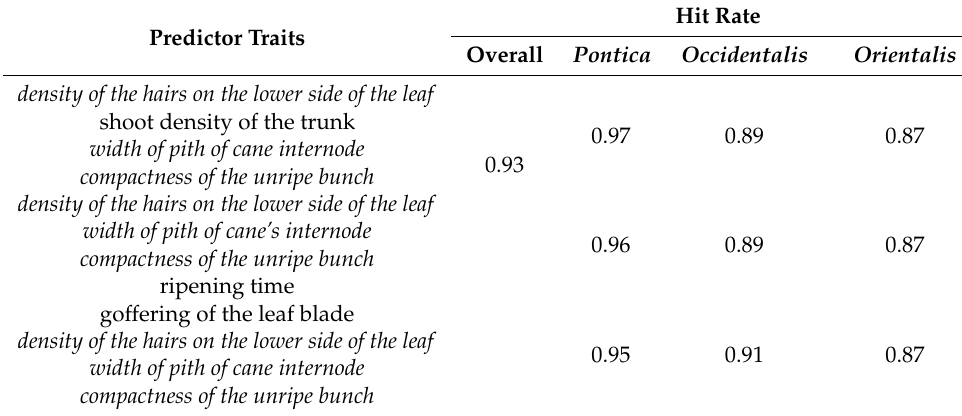
Table 1. The rate of correct classifications in the test set (overall hit rate) and the subsets pontica, occidentalis, and orientalis resulted in using four predictors with the random forest method. The best three-predictor-combination set is in italic.